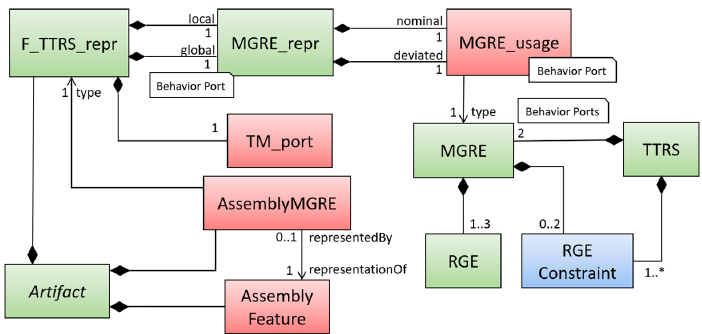
Figure 7. Abstract syntax of TTRS ‐ based concepts (“*” is a “zero to many” multiplicity).